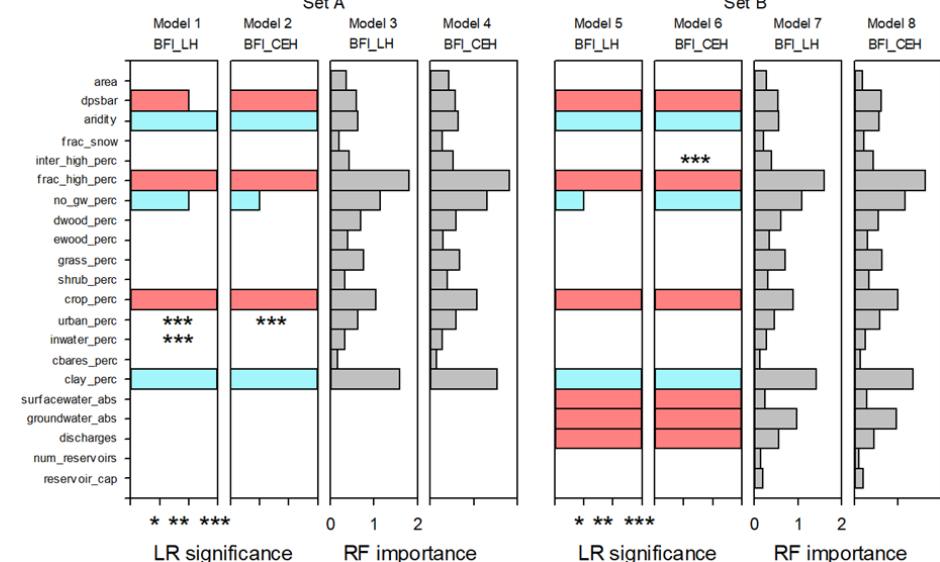
Figure 5. Signs and significance levels of the covariates in the LR models and the relative importance of covariates in the RF models. The signs of the significant covariates in the LR models are indicated using colour (pink for positive, blue for negative), and the corresponding significance levels of the covariates are indicated on the x axis with asterisks ( ∗ for significance level between 0.05 and 0.1, ∗∗ for significance level between 0.01 and 0.05, ∗∗∗ for significance level below 0.001). Some covariates were only significant prior to accounting for the spatial correlations. These are marked with asterisks only in the figure at their respective level of significance. Table A1 gives full details of the regression coefficients. Relative RF importance ranges from zero to 2. Table 3 gives the scores for the relative importance of covariates in the four RF models. Table 1. Lin’s concordance coefficients between LR model predictions and the data.